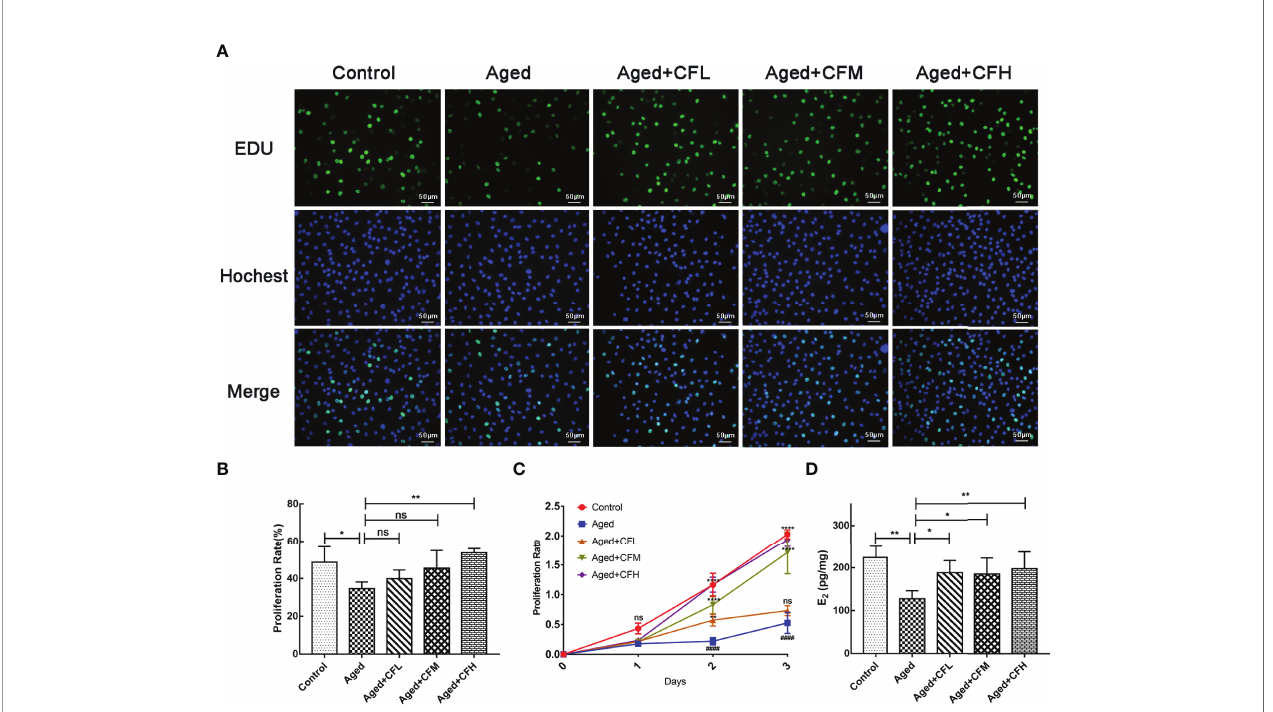
FIGURE 5 | CEFFE recovers proliferation and E 2 secretion of senescent KGN cells. (A) Proliferation of KGN cells was measured via EdU assay. Proliferative cells were labeled via green fl uorescence, and all nuclei were labeled via blue fl uorescence. Scale bar=50 m m. (B) Statistics of proliferative cell rates. (C) Proliferation of KGN cells was measured using the CCK-8 assay at 24 h, 48 h, and 72 h. (D) The E 2 content in cellular supernatant was measured via ELISA, and the results were standardized with the concentration of KGN cell proteins in each group. Three independent experiments were conducted in each group, and data are represented as the mean ± SD, ns: P > 0.05, * P < 0.05, ** P < 0.01, **** P < 0.0001, #### P < 0.0001 *Compared with Aged group, # Compared with Control